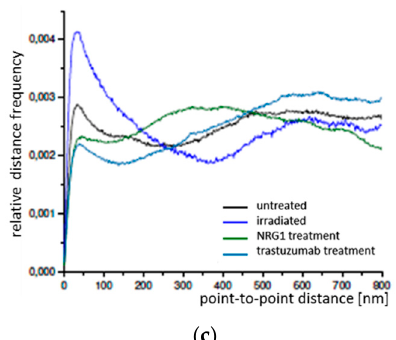
Figure 8. Relative distance frequency histograms of the next neighbor distances of fluorescently labelled Cx43 molecules in BJ cells for the different treatment scenarios. The distances forming the peaks in ( a ) and ( b ) correlate to connexons. ( a ) peripheral regions; ( b ) perinuclear regions; ( c ) Cx43 accumulations at the cell border. Note the different abscissa in ( c ).